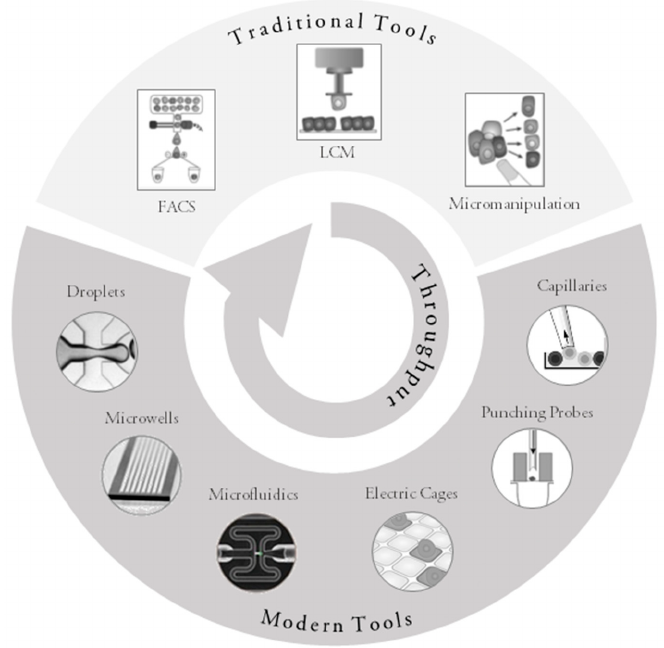
Figure 1. Overview of currently used tools and principles for single-cell collection (adapted and modified from materials provided by the manufacturers and [74,82] with permission from Elsevier). FACS: fluorescence-activated cell sorting; LCM: laser capture